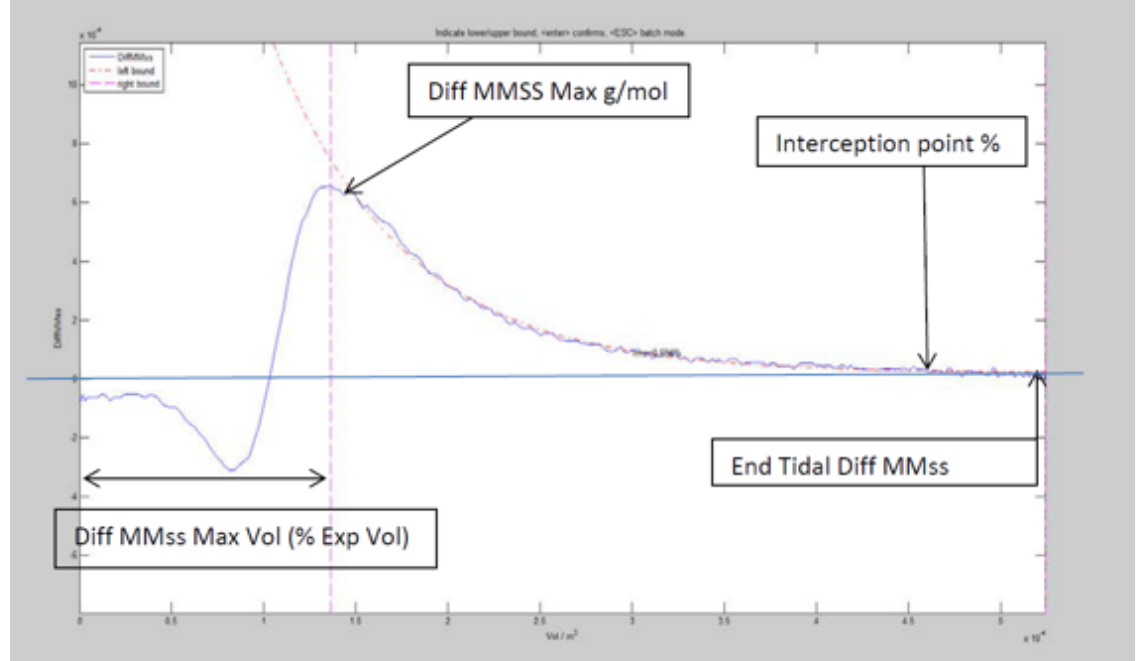
Figure S3: Fit lines of double tracer gas single breath washout (DTG-SBW), differences in molar mass (MM) plotted against expired